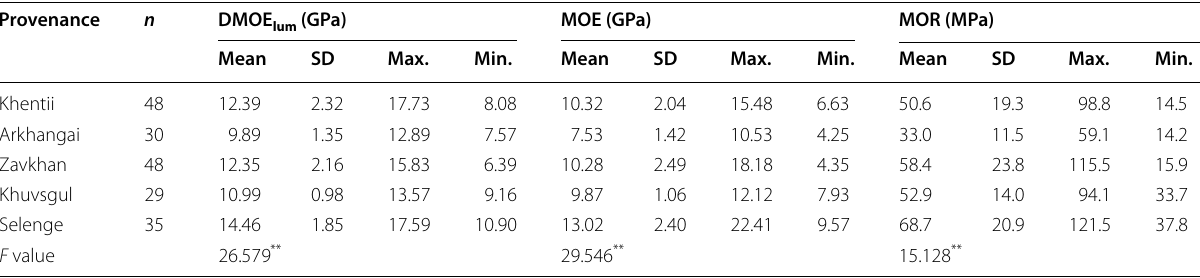
Table 5 Mean values and standard deviations of dynamic Young’s modulus and bending properties of the lumber